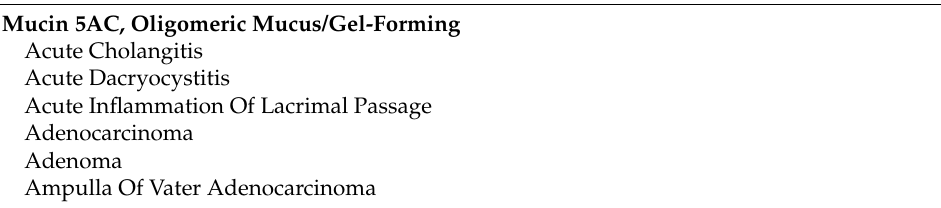
Chromosomal Disease Conjunctival